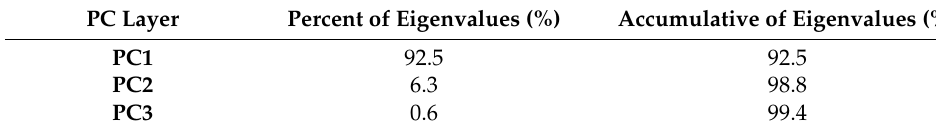
Table A1. Percent and accumulative eigenvalues of three first PCs.